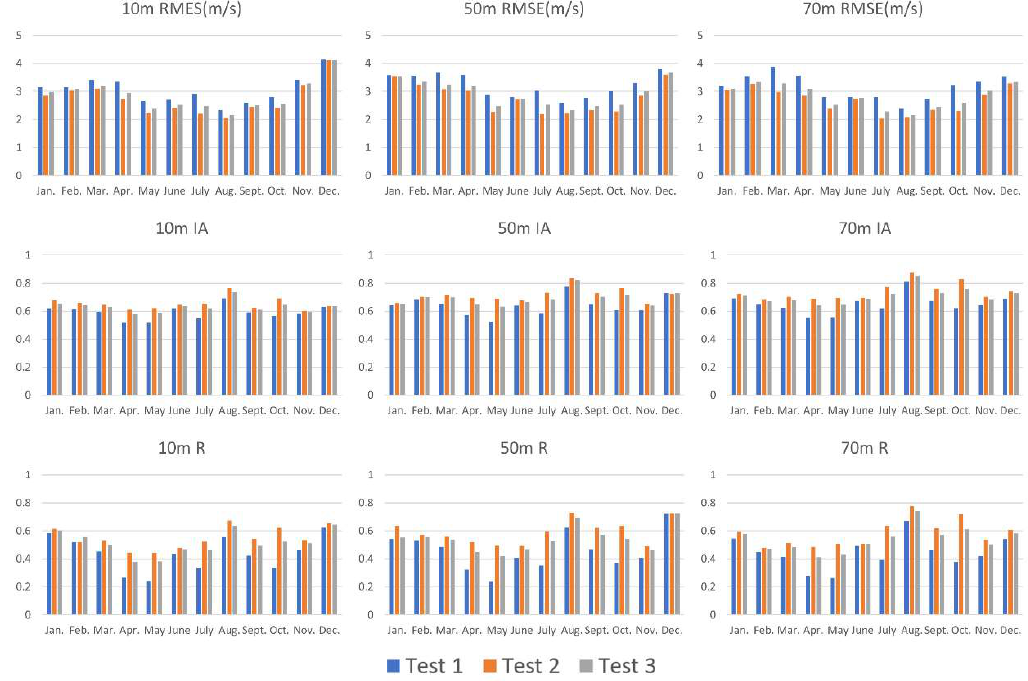
Figure 7. Average of the results of root-mean-square error (RMSE), index of agreement (IA), and Correlation Coe ffi cient (R) from the seven towers.